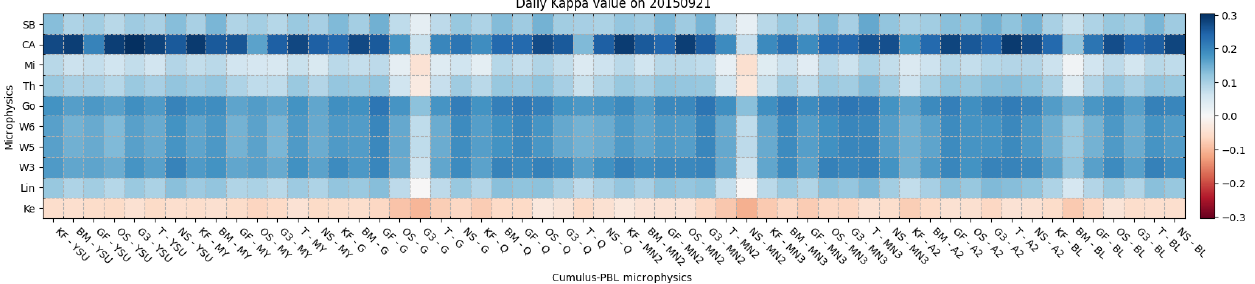
Figure 7. The heat map of average κ for every configuration for the clusters of microphysics ( y axis) with the cluster of cumulus parameter- ization and PBL ( x axis) for the simulation case on 21 September for Set 1. The data only use the last 36h of simulations for calculating κ .